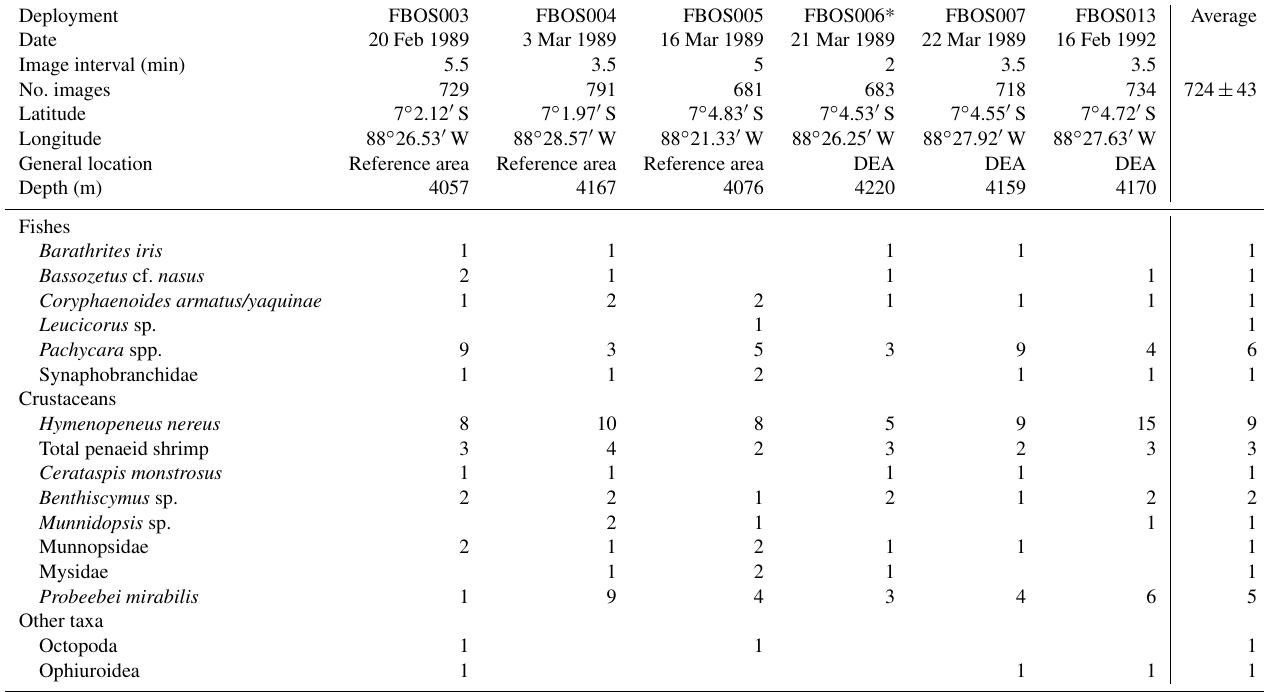
Table 2. Deployment MaxN for each bait-attending species by camera deployment (FBOS system). DEA – DISCOL experimental area.